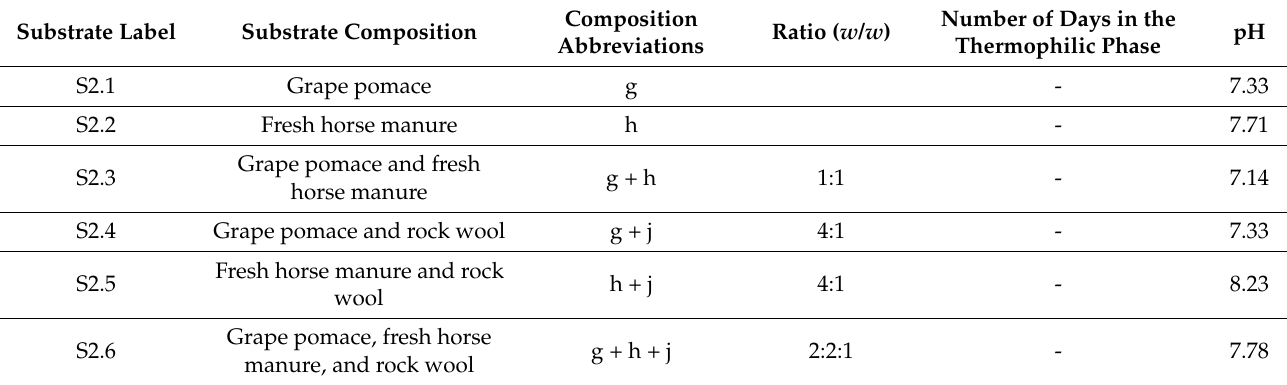
Table 2. Details of the second set of substrates.